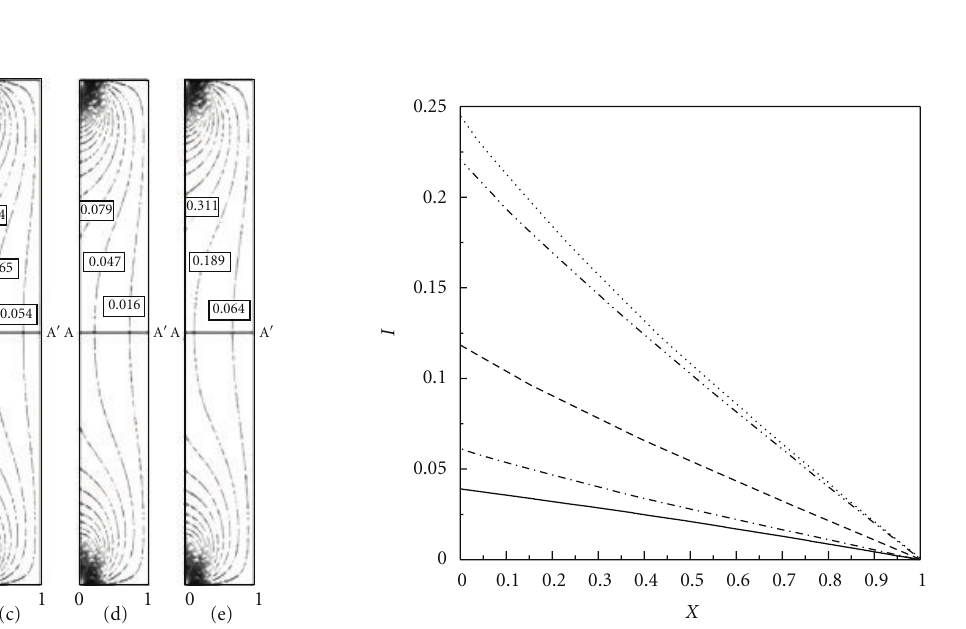
Figure 15: The distribution of dimensionless current at A-A (cid:2) with Figure 13: Distribution of dimensionless current density at l = di ff erent operation temperature and methanol concentration l = 10 μ m, a = 1 . 0 × 10 5 m − 1 , E 0 = 0 . 5V, κ e = 3 . 4 Ω − 1 m − 1 , D e = = 1 . 0 M; (b) T = 333 K, 10 μ m, a = 1 . 0 × 10 5 m − 1 , E 0 = 0 . 5 V, κ e = 3 . 4 Ω − 1 m − 1 , D e = 3 . 04 × 10 − 10 m 2 s − 1 ; (a) T = 303K, c 0 M = 1 . 0 M, dash line: 3 . 04 × 10 − 10 m 2 s − 1 , solid line: T = 303K, c 0 c 0 M = 1 . 0 M; (c) T = 363 K, c 0 M = 1 . 0M; (d) T = 333 K, c 0 M = 0 . 5 M; M = 2 . 0M. The dimensionless current densities on T = 333K, c 0 M = 1 . 0 M, dot line: T = 363 K, c 0 M = 1 . 0 M, dash (e) T = 333K, c 0 M = 0 . 5 M, dash dot dot line: T = 333 K, dot line: T = 333 K, c 0 the points of A are (a) 0.039, (b) 0.118, (c) 0.245, (d) 0.061, and (e) M c 0 M = 2 . 0 0.221.